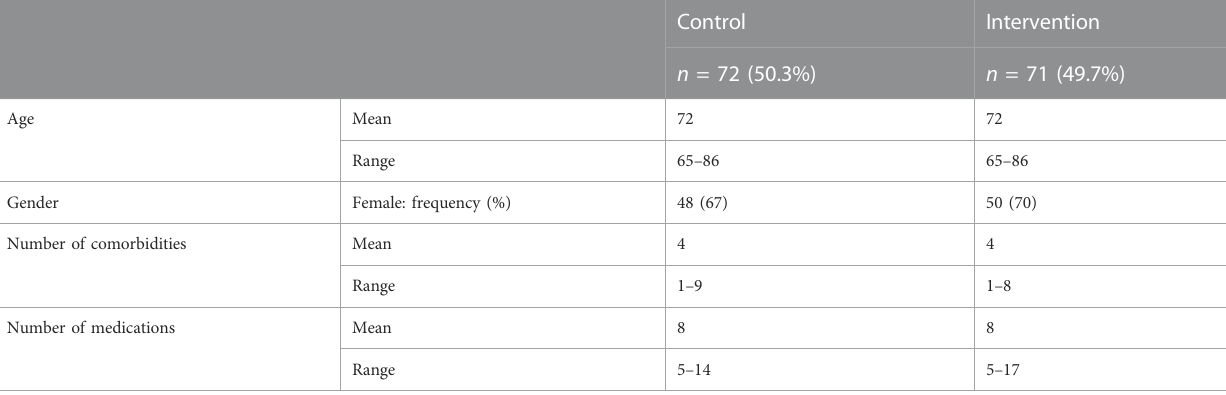
TABLE 2 Participants ’ characteristics and descriptive statistics.